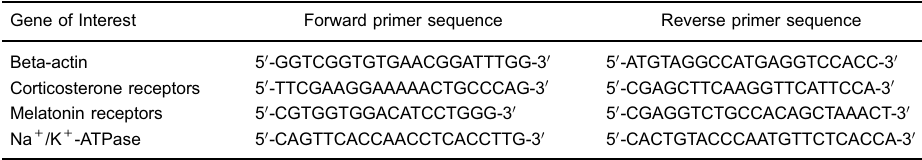
Table 1. Gene-speci fi c primer pairs for quantitative real-time PCR of hippocampal Na + /K + -ATPase, corticosterone receptors, and melatonin receptors. Gene of